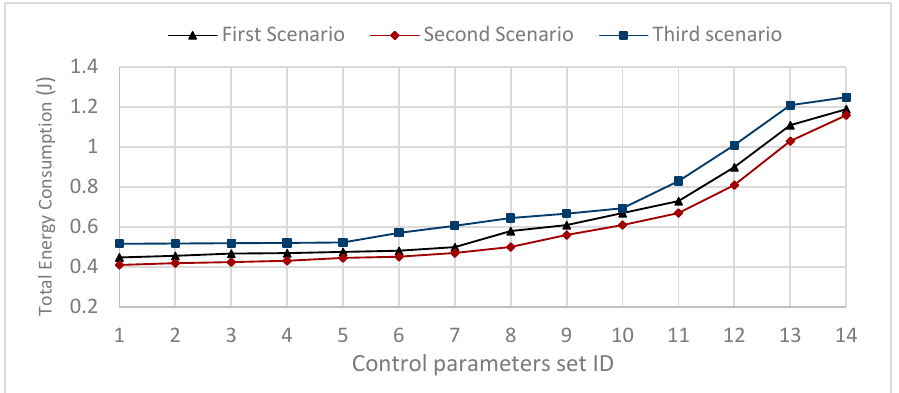
Figure 6. Impact of control parameters sets on total energy consumption for first scenario, second scenario and third scenario.